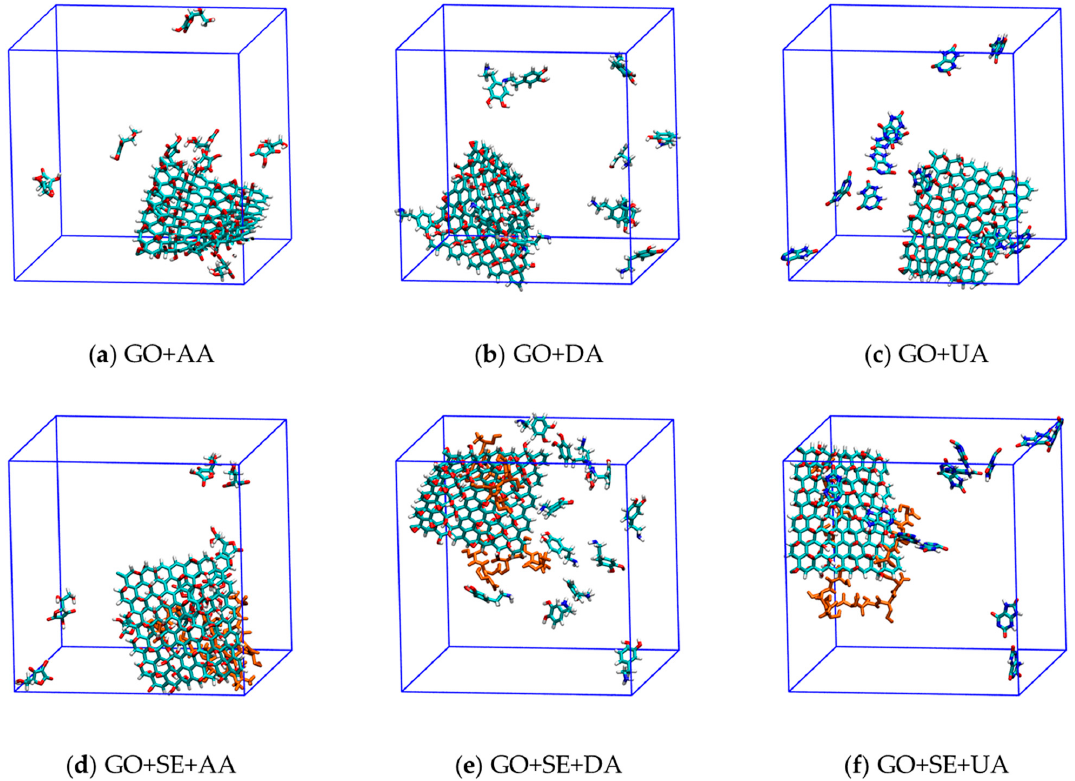
Figure 2. Starting structures for all atomistic MD simulations: ( a ) GO + AA; ( b ) GO + DA; ( c ) GO + UA; ( d ) GO + SE + AA; ( e ) GO + SE + DA; and ( f ) GO + SE + UA.